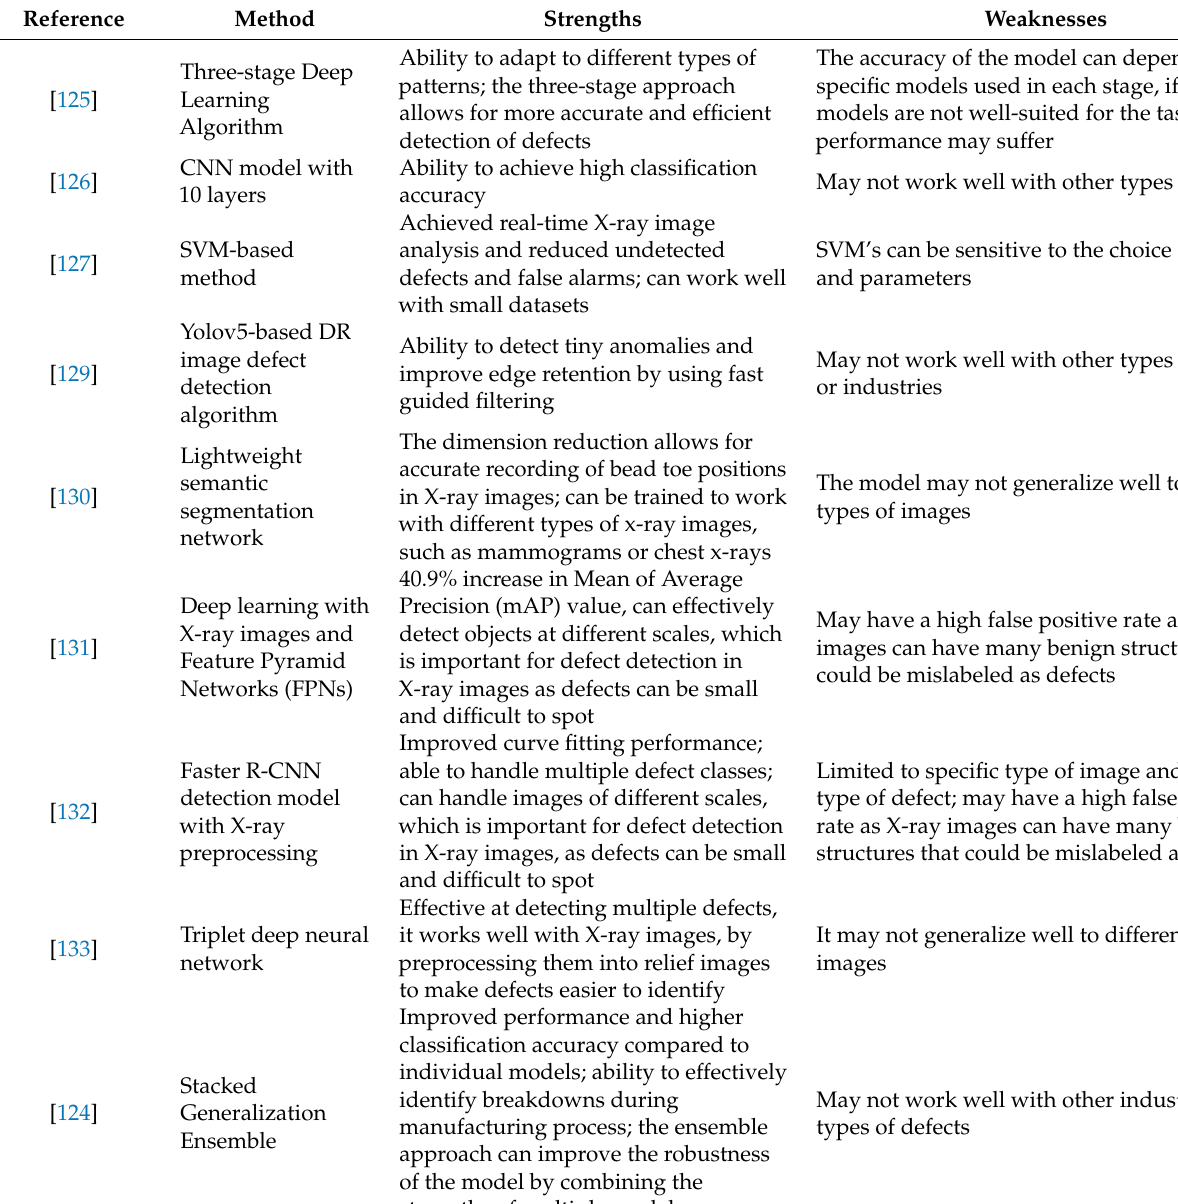
Table 7. Strengths and weaknesses of different deep-learning techniques for identifying defects in X-ray